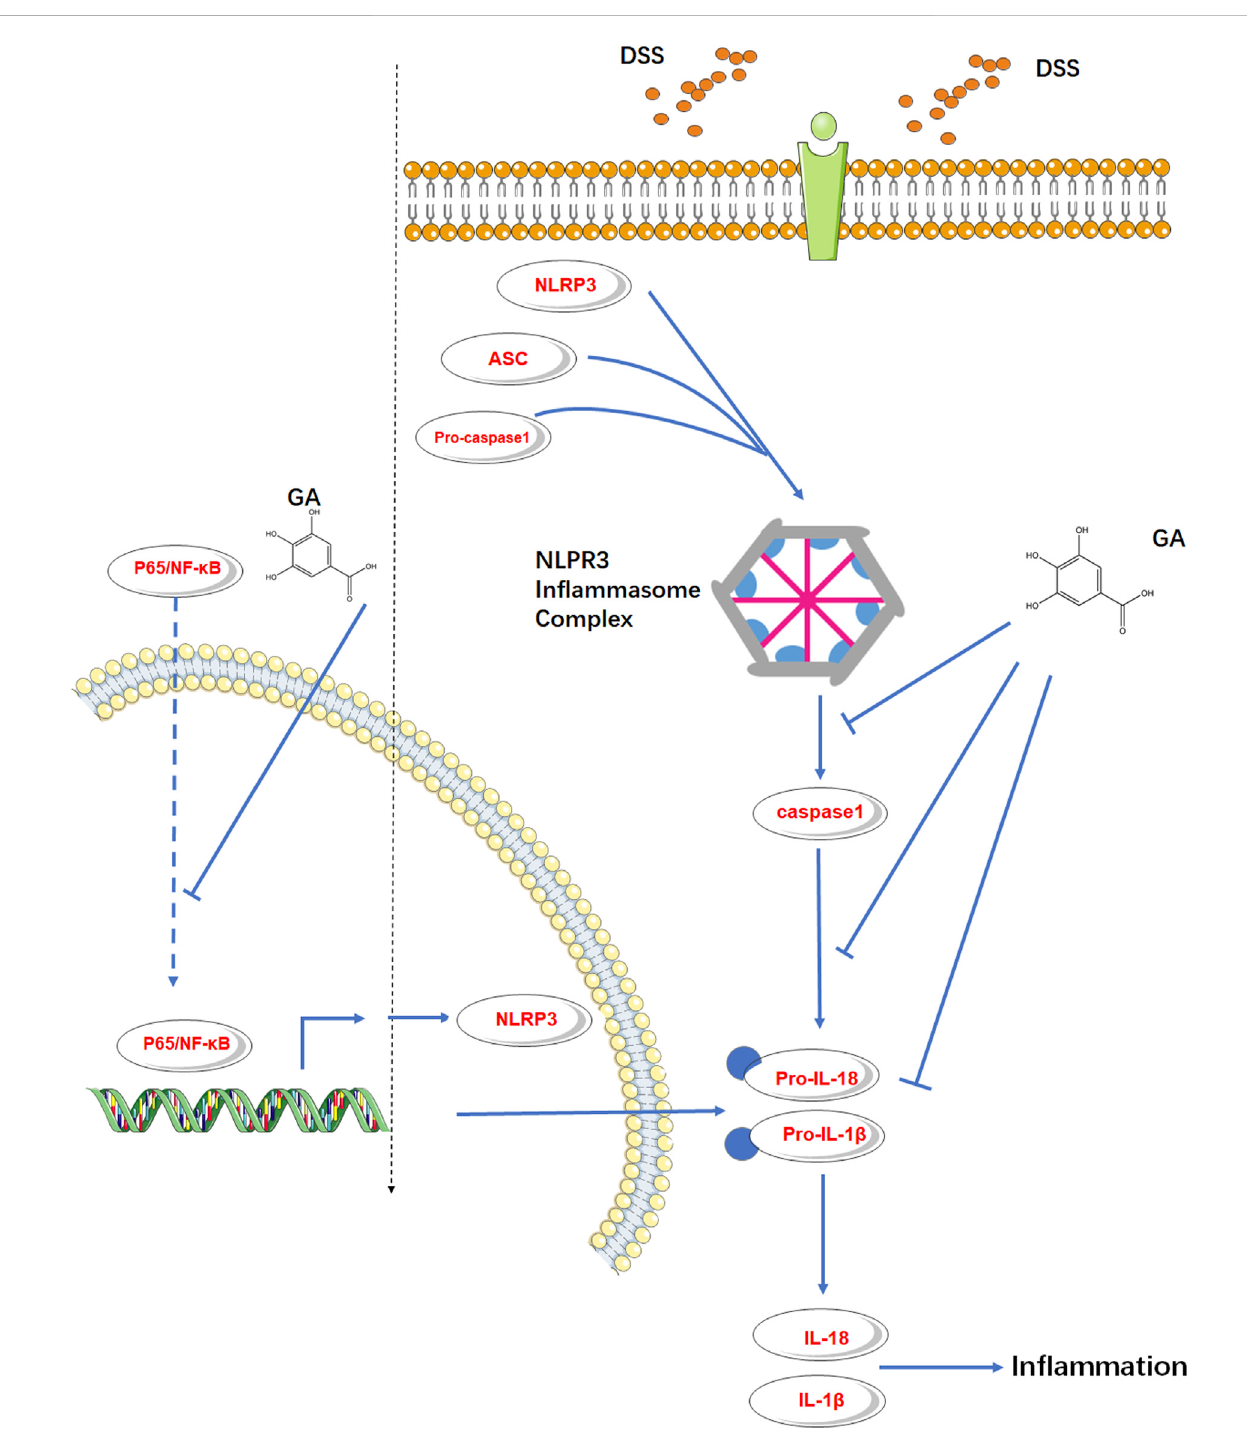
FIGURE 6 GA inhibited the endogenous NLRP3 expression and NLRP3 in fl ammasome activation in murine